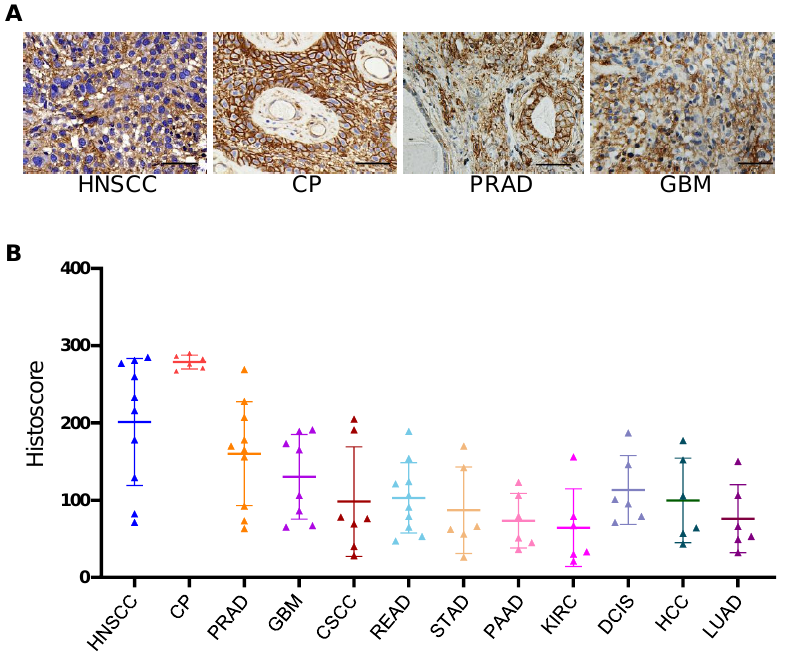
Figure 1. IHC staining analysis of B7-H3 expression in clinical tumor samples. ( A ) Immunohisto- chemical staining analysis. ( B ) Semi-quantitative analysis. Scale bar: 50 µ m.